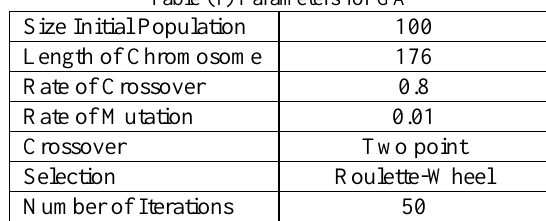
Table (1)-Parameters for GA